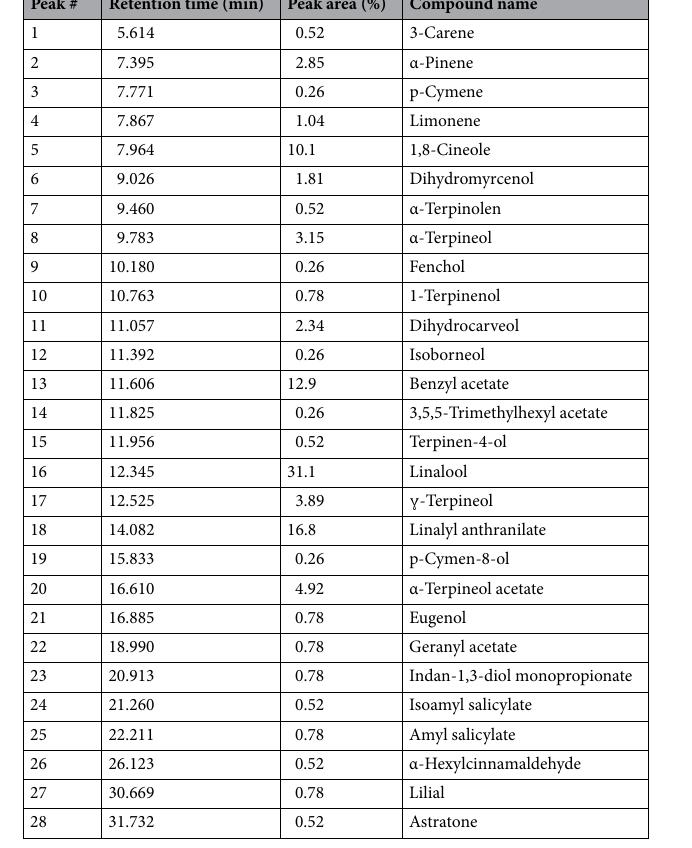
Table 2. Chemical composition of lavender essential oil using GC–MS